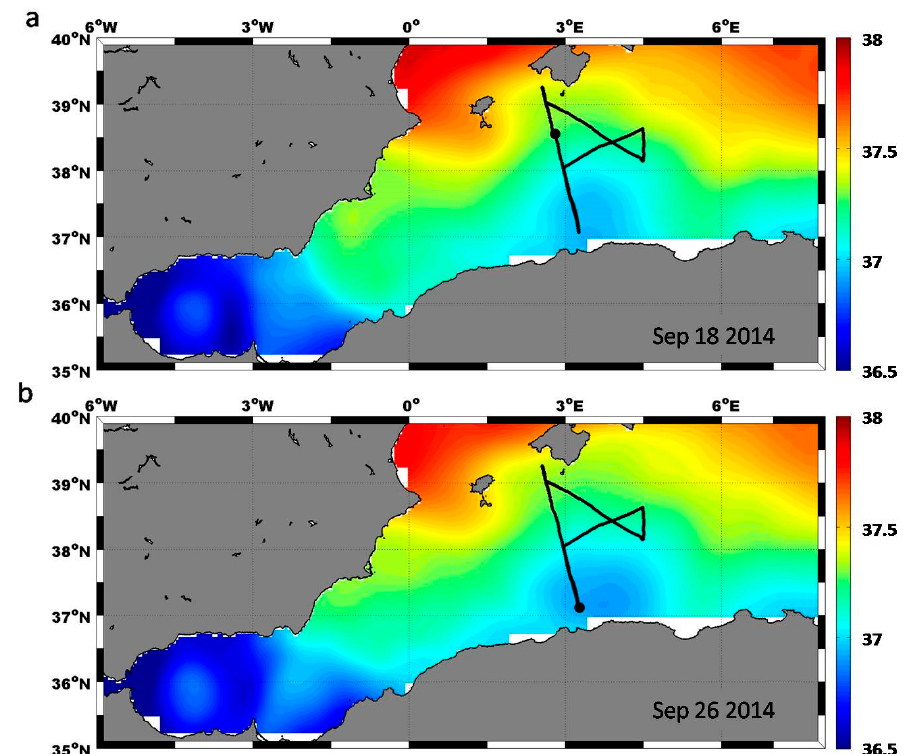
Figure 8. SMOS L4 Sea Surface Salinity (SSS) maps of the Alboran Sea and the Algerian Basin on 18 September and 26 September 2014—ABACUS 1.1 survey. Glider track in black.